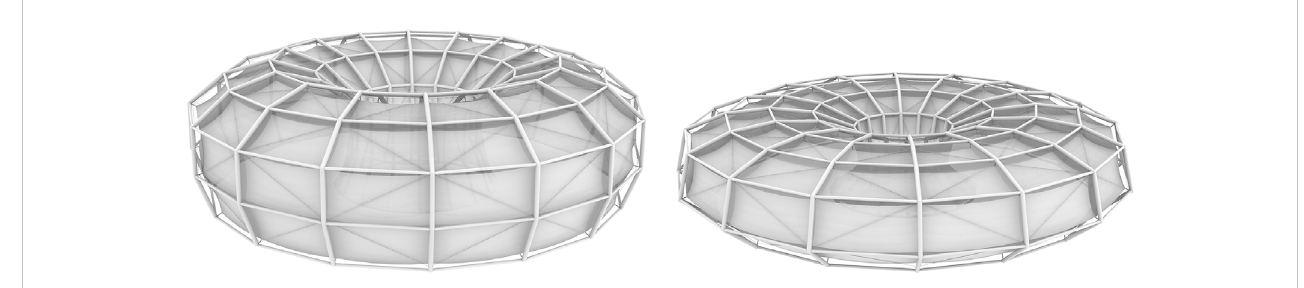
FIGURE 2 Transformable building in initial and target